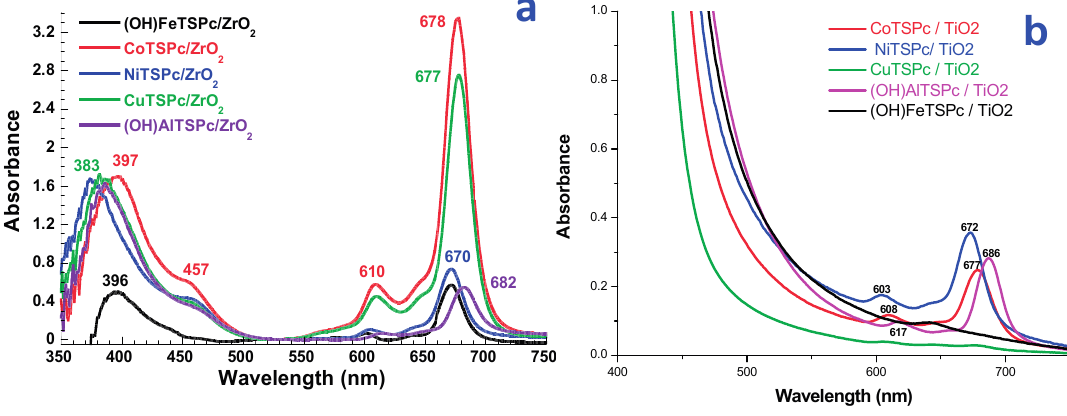
Figure 3. UV-vis spectra of final ( a ) ZrO 2 and ( b ) TiO 2 monolithic xerogel pore networks (using blank-ZrO 2 or blank-TiO 2 as background) containing encapsulated MTSPc species (M ≡ Fe, Co, Ni, Cu and